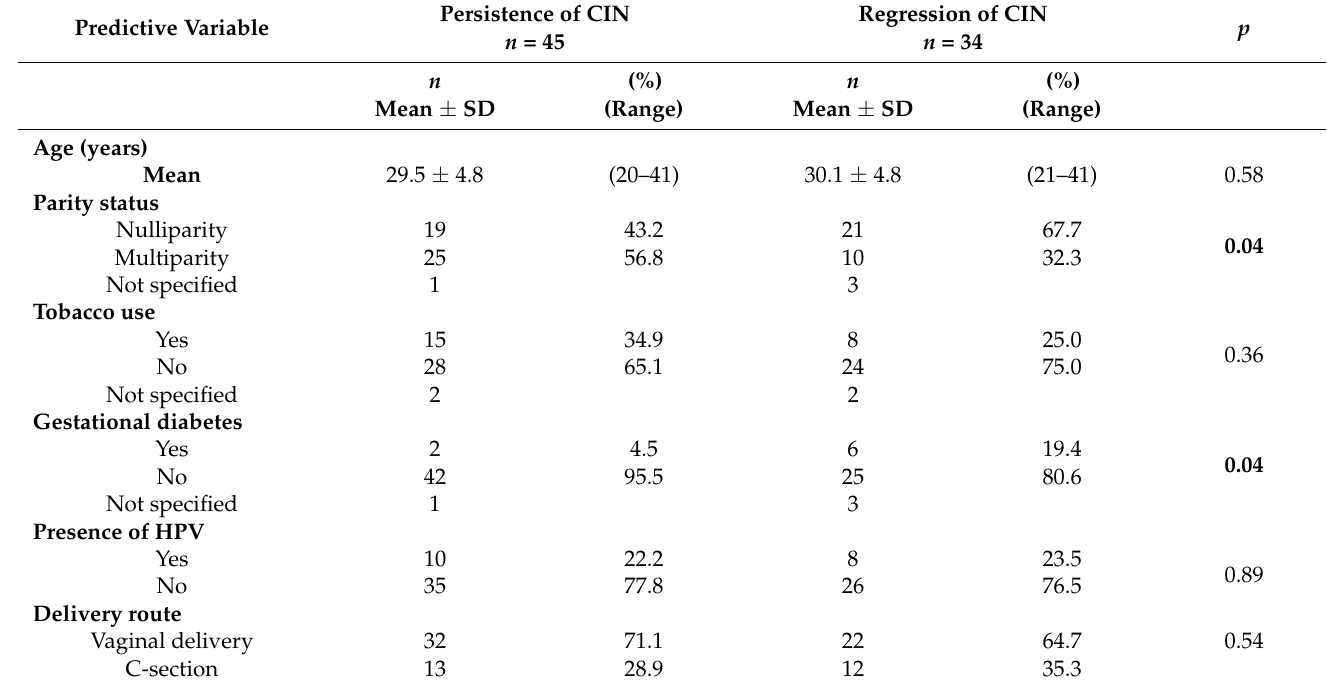
Table 3. Univariate analysis of general factors associated with postpartum CIN